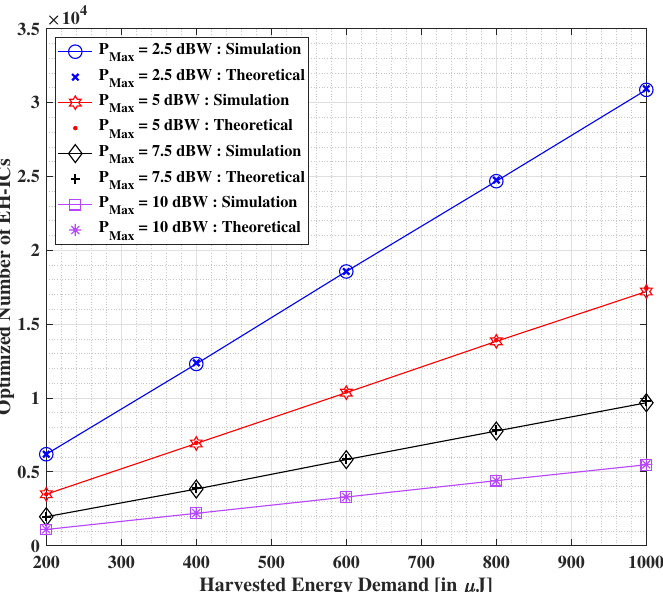
Figure 10. Optimized number of RF-EH ICs versus the overall demanded harvested energy demand for altering values of P Max .